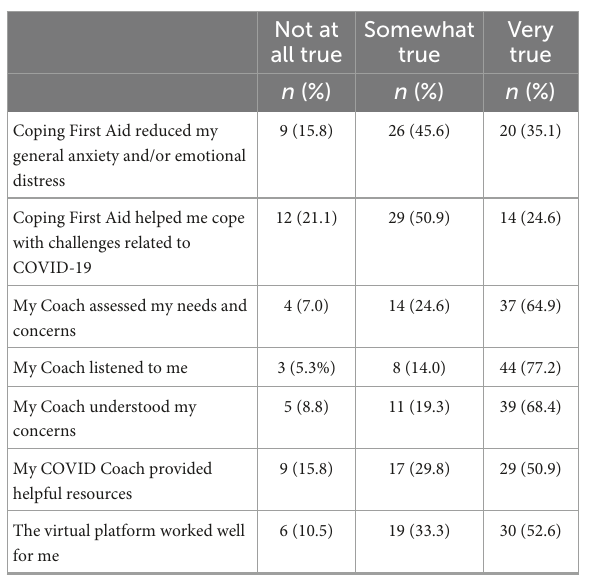
TABLE 2 Client satisfaction and perceived efficacy of the Coping First Aid (CFA) program from client survey respondents ( N = 57) 1 .